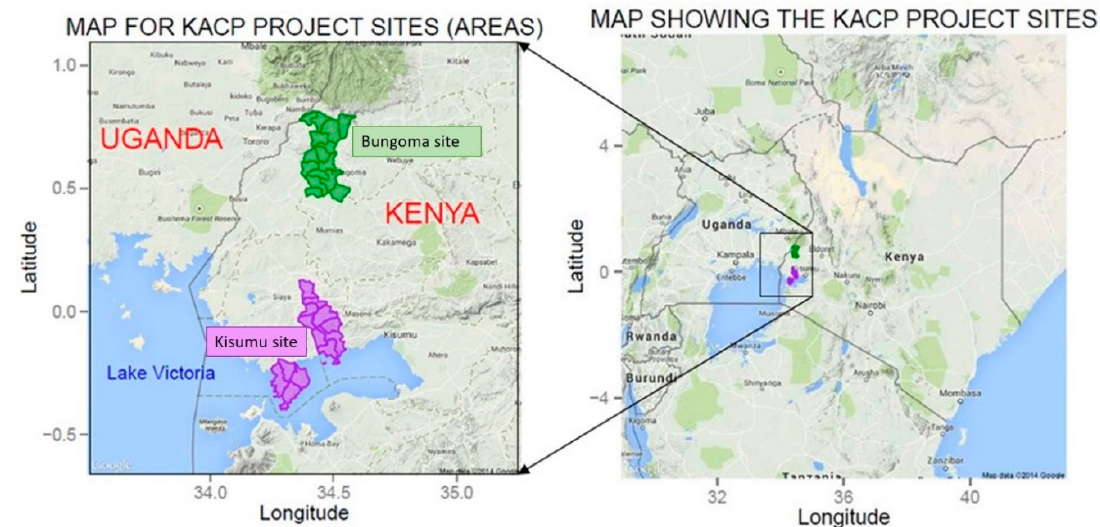
Figure 1. Left: Kenya Agricultural Carbon Project (KACP) areas; the Bungoma sites in Bungoma County (green) and the Kisumu sites in Kisumu and Siaya Counties (purple). Right: The KACP areas within East Africa.